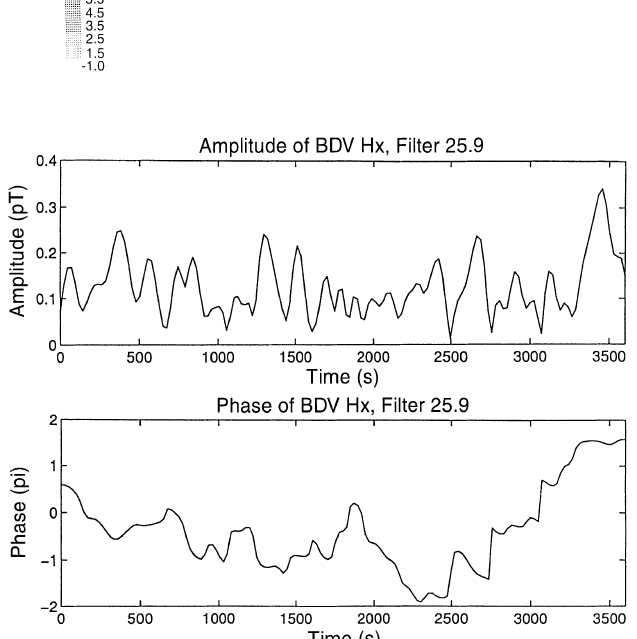
Fig. 3. Dynamic spectrum of the 0800 to 0900 UT, 18 June, 1991, event at KAK